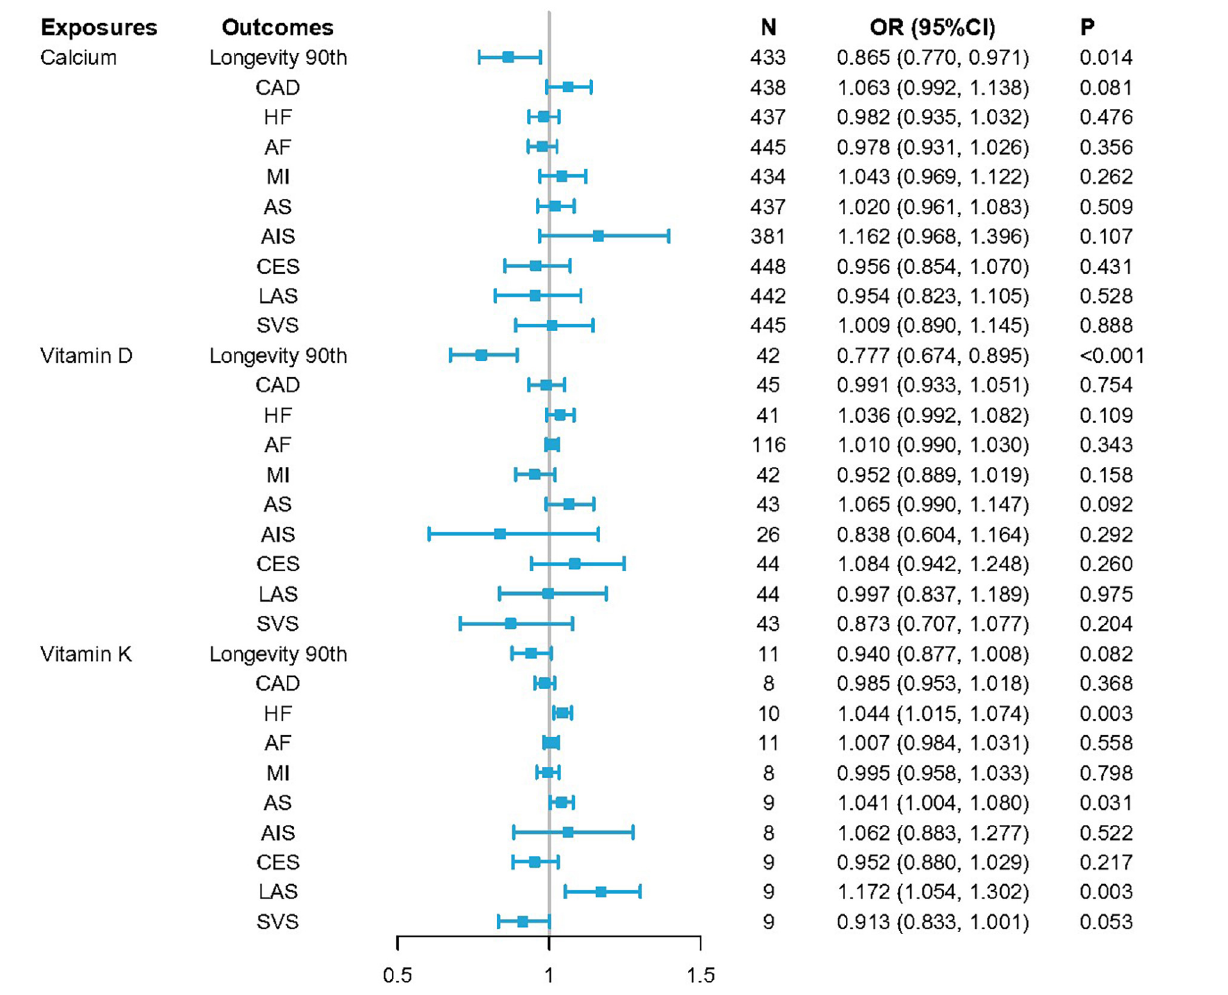
FIGURE2 OR SD for causal associations between serum levels of calcium (Ca), vitamin D (VD), and vitamin K1 (VK1), and cardiovascular diseases (CVDs) as well as longevity. Odds ratio (OR) estimates for individual single nucleotide variants (SNVs) were made using the inverse-variance-weighted (IVW) method. OR SD = OR for standard deviation (SD) unit increases in risk